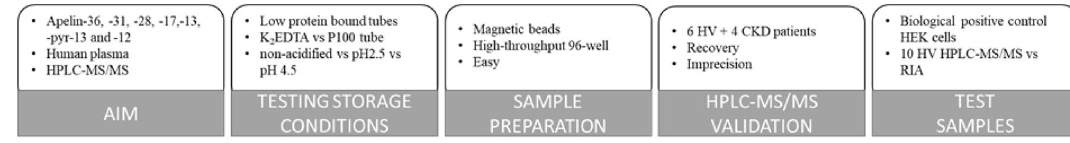
Figure 2. Schematic overview of the experimental design. HV healthy volunteer, CKD chronic kidney